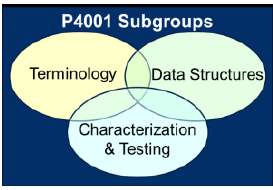
Figure 2 . P4001 subgroups.